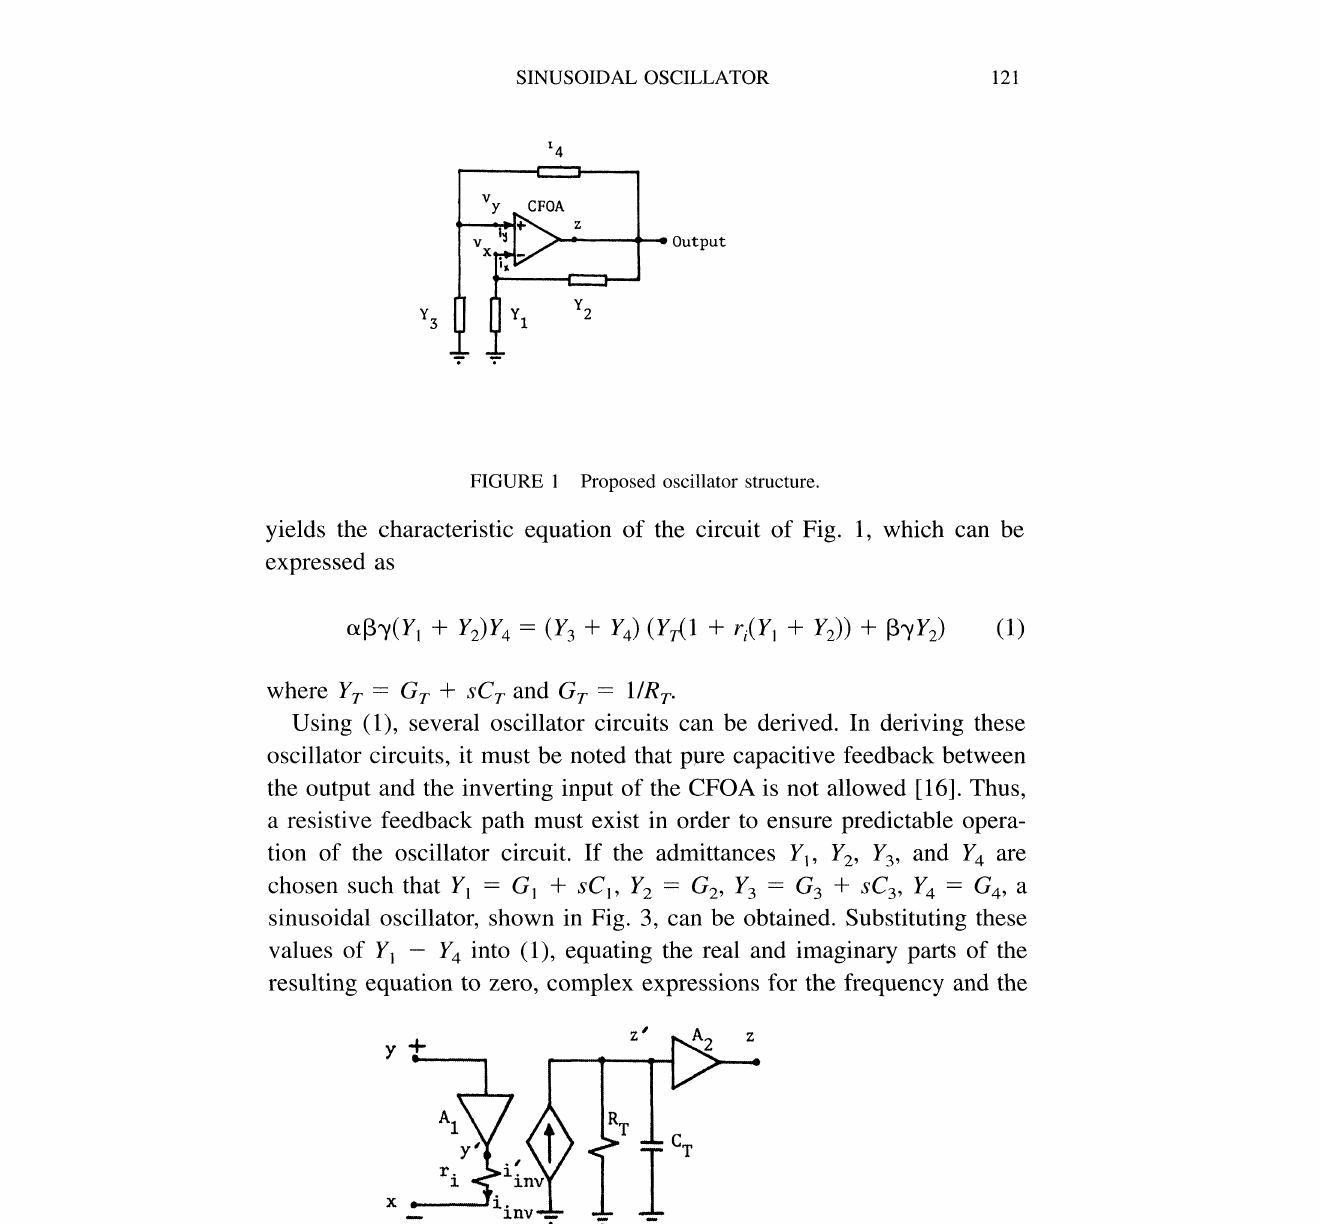
FIGURE 2 Simplified equivalent circuit for the